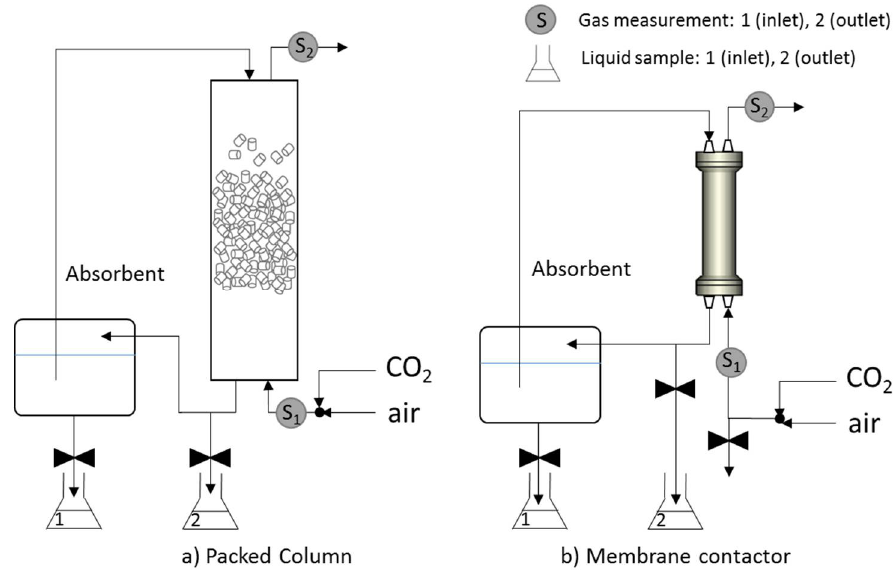
Figure 1. Experimental set ups for CO 2 capture.